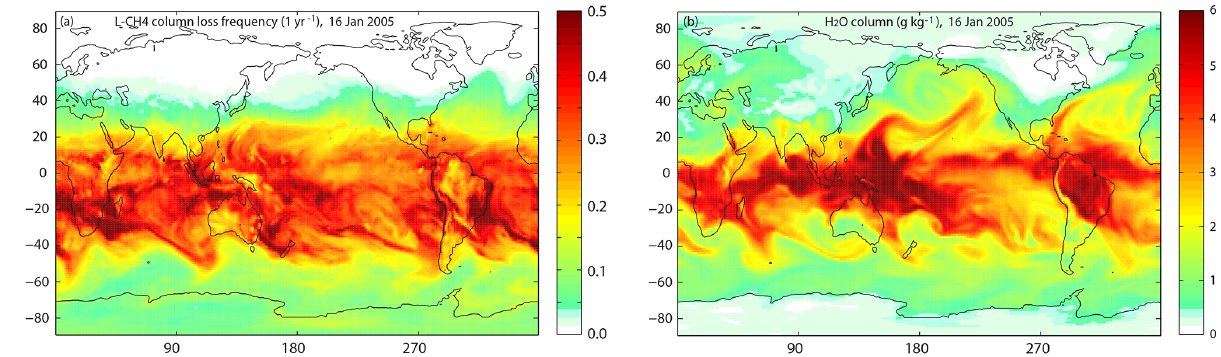
Figure 1. (a) Column tropospheric loss frequency (1yr − 1 ) for CH 4 and (b) column average H 2 O abundance (g-H 2 Okg-air − 1 ) taken from a 1-day integration (16 January 2005) using the University of California, Irvine (UCI) chemistry-transport model (CTM) run at T319N80L57 resolution ( ∼ 1 ◦ horizontal) using forecast meteorology from the European Centre for Medium-Range Weather Forecasts, see Sovde et al. (2012). As expected, the northern winter shows very little CH 4 loss above 40 ◦